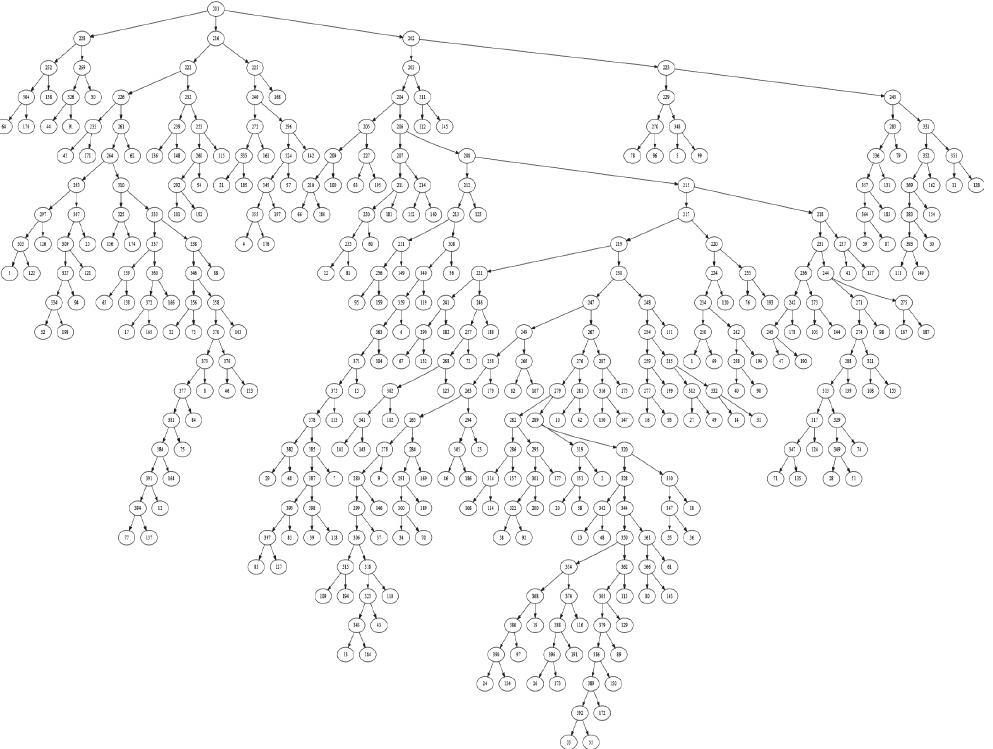
Figure 10: Distance hierarchy cluster tree.